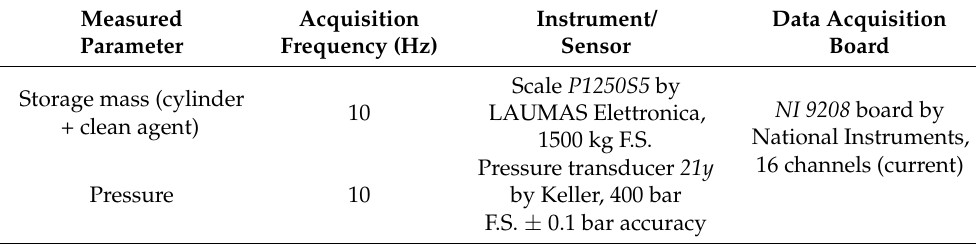
Table 1. Employed measuring instruments and relevant